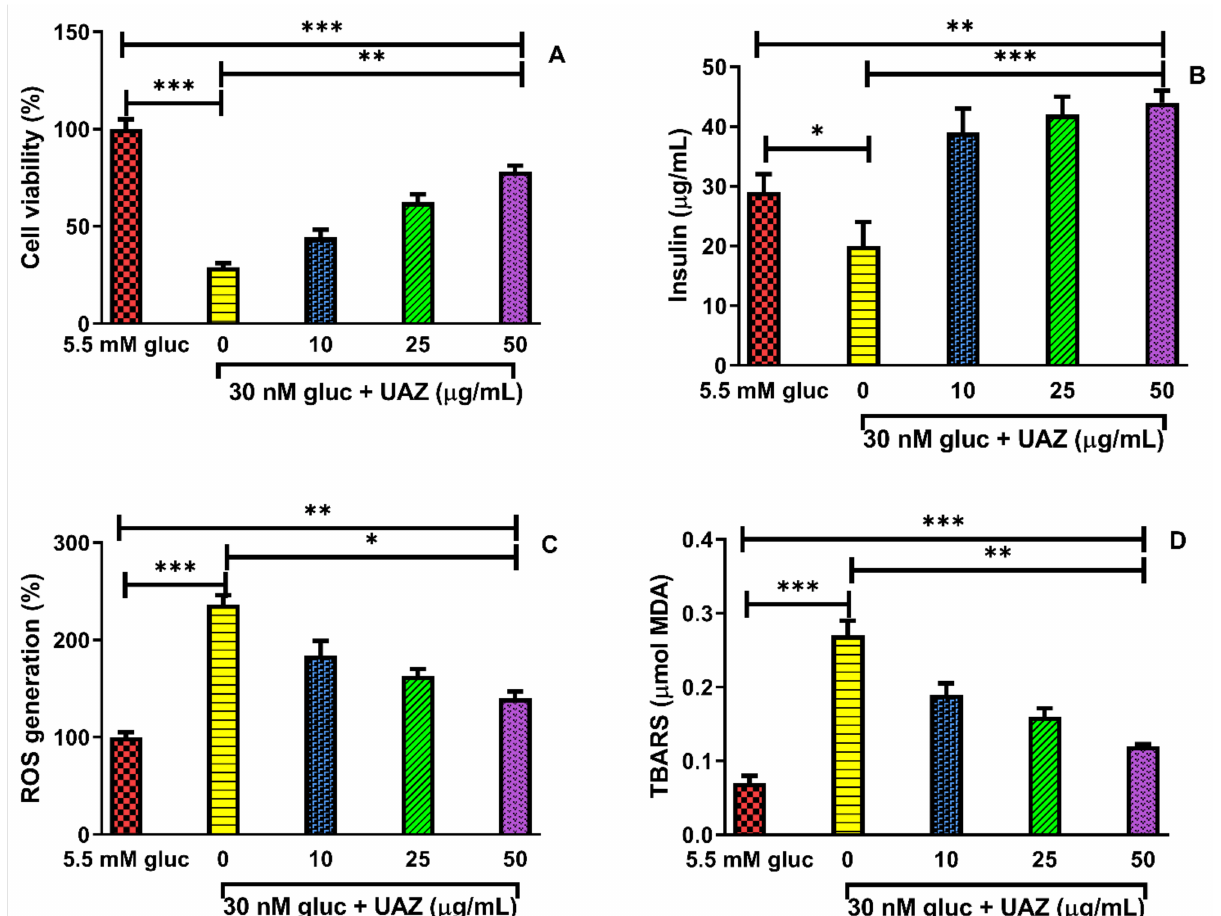
Figure 4. ( A ) UAZ enhance pancreatic b-cell viability when RINm5F cells were incubated in RPMI1640 medium containing glucose at 30 mM with or without various concentrations of (UAZ; 10, 25, and 50 µ g/mL) for 48 h; ( B ) UAZ improved high glucose impaired insulin secretion; ( C ) Effect of UAZ on intracellular levels of reactive oxygen species (ROS) in high glucose-treated RINm5F cells; ( D ) TBARS generation in high glucose-treated INS-1 pancreatic β -cells. The use of 5.5 mM glucose was representative of normal glucose conditions and the 30 mM glucose treatments represent high glucose conditions. Data are expressed as the mean ± SD, * p < 0.05, ** p < 0.01, and *** p <